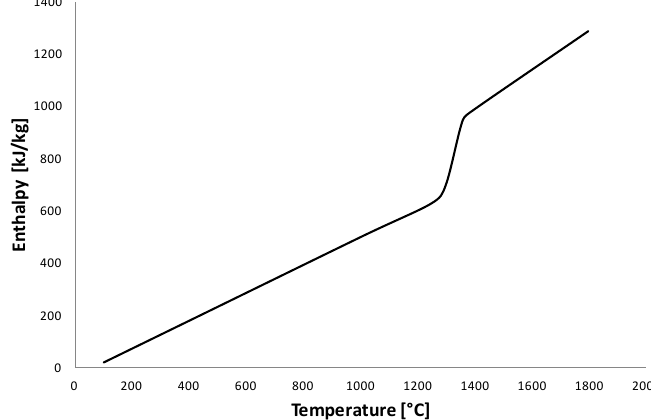
Figure 3. Liquid-solid phase distribution for IN718 powder shown on the basis of the enthalpy change as a function of temperature based on data from [27,28].